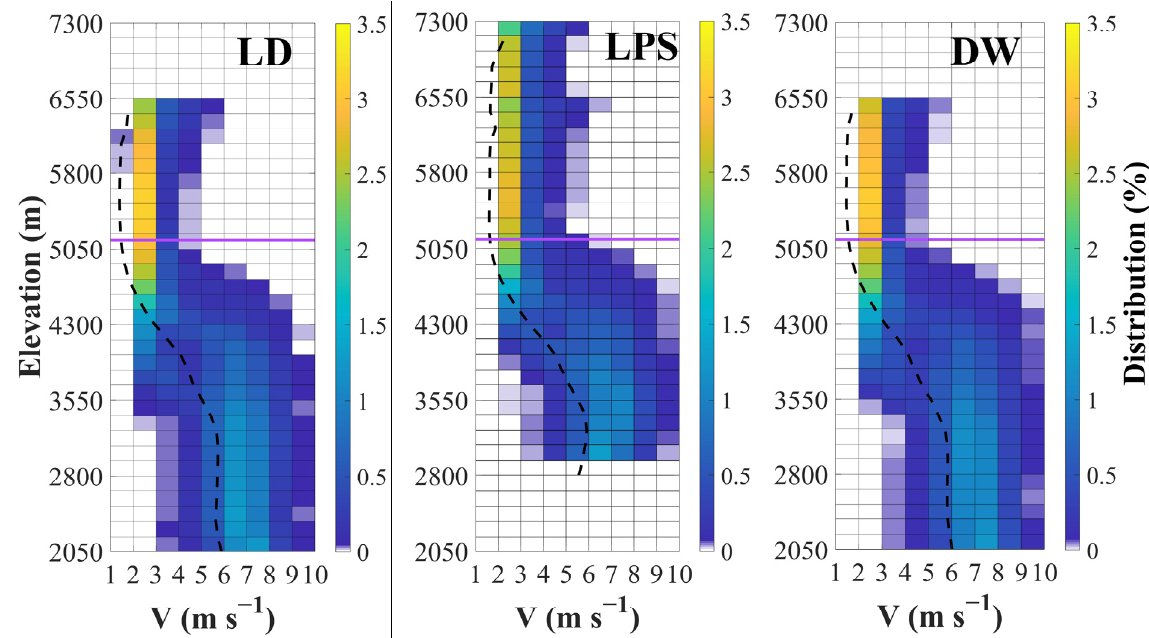
Figure 5. Vertical profiles of hydrometeors’ fall velocity at the three MRR-2 sites. Color shading represents the frequency of occurrence relative to the maximum absolute frequency in a site’s data sample represented in the CFAD, classified every 5% with the minimum step level at 1%. The ordinate of the CFAD is altitude (150 m bins) and the abscissa is fall velocity (m s − 1 , 1 m s − 1 bins). The black dotted line that goes through each panel represents the mean value of hydrometeors’ fall velocities. The purple line represents the mean level of the 0 °C isotherm derived from the RPG at LD.